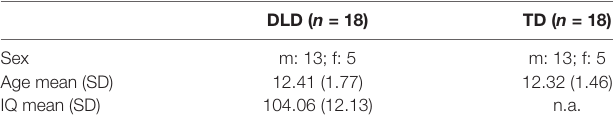
TABLE 1 | Demographic data for the developmental language disorder (DLD) and typically developing (TD)